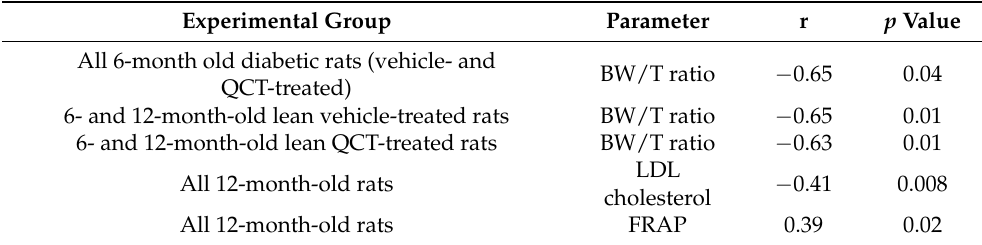
Table 1. Correlations between erythrocyte deformability and biometrical and biochemical parameters. Experimental